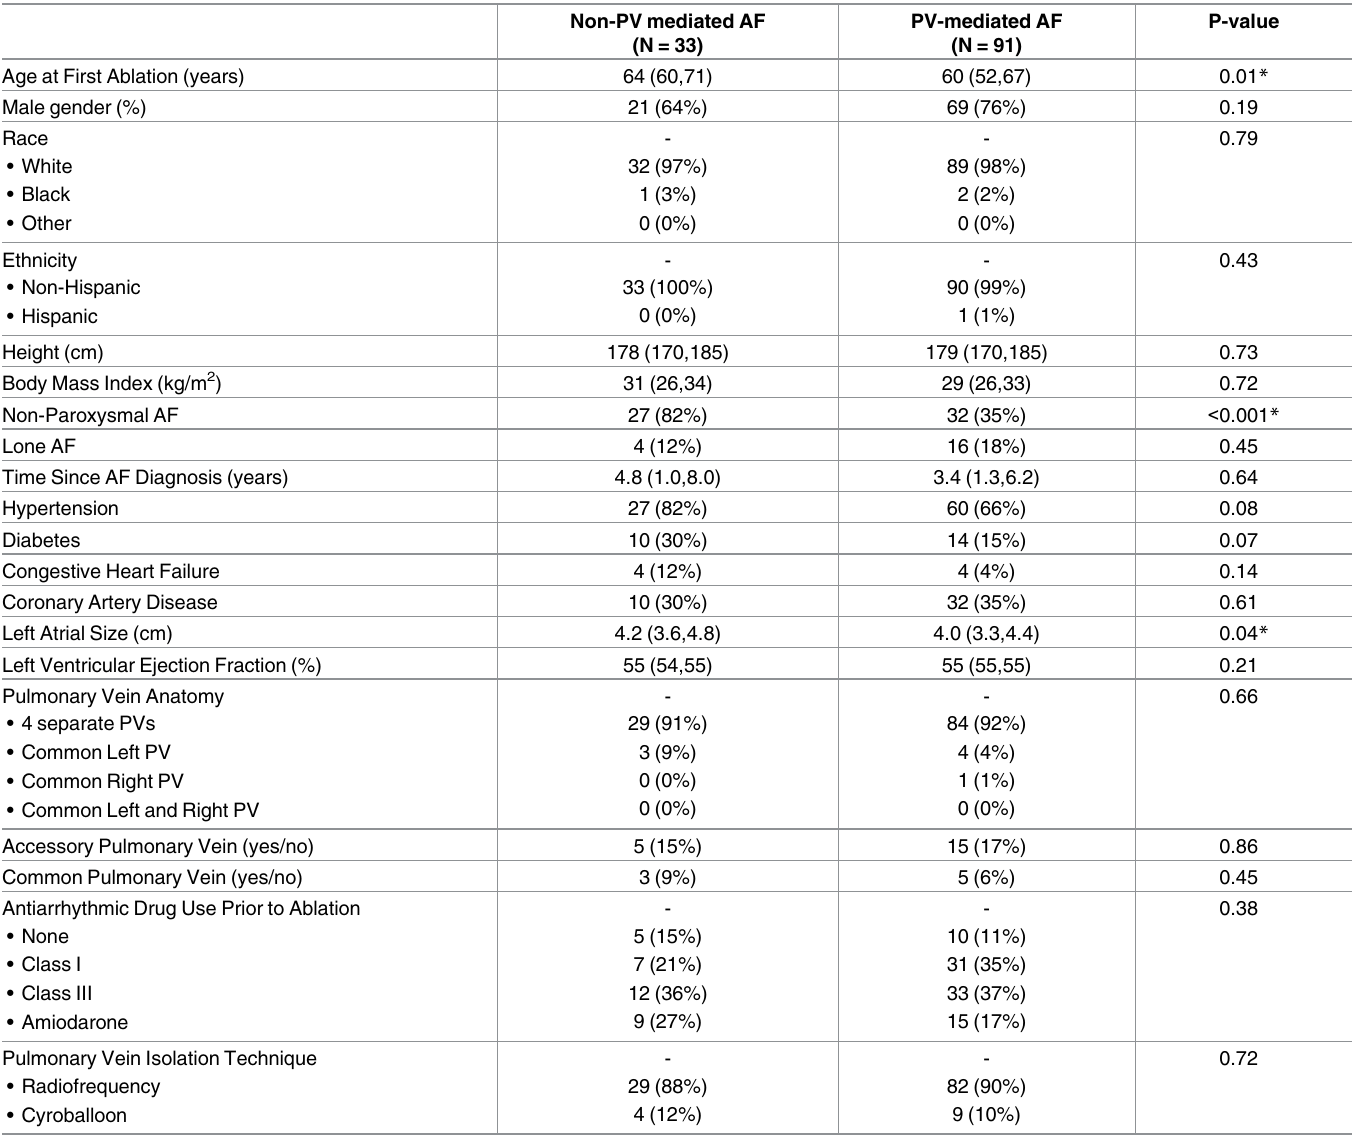
Table 3. Comparison of pulmonary vein and non-pulmonary vein mediated